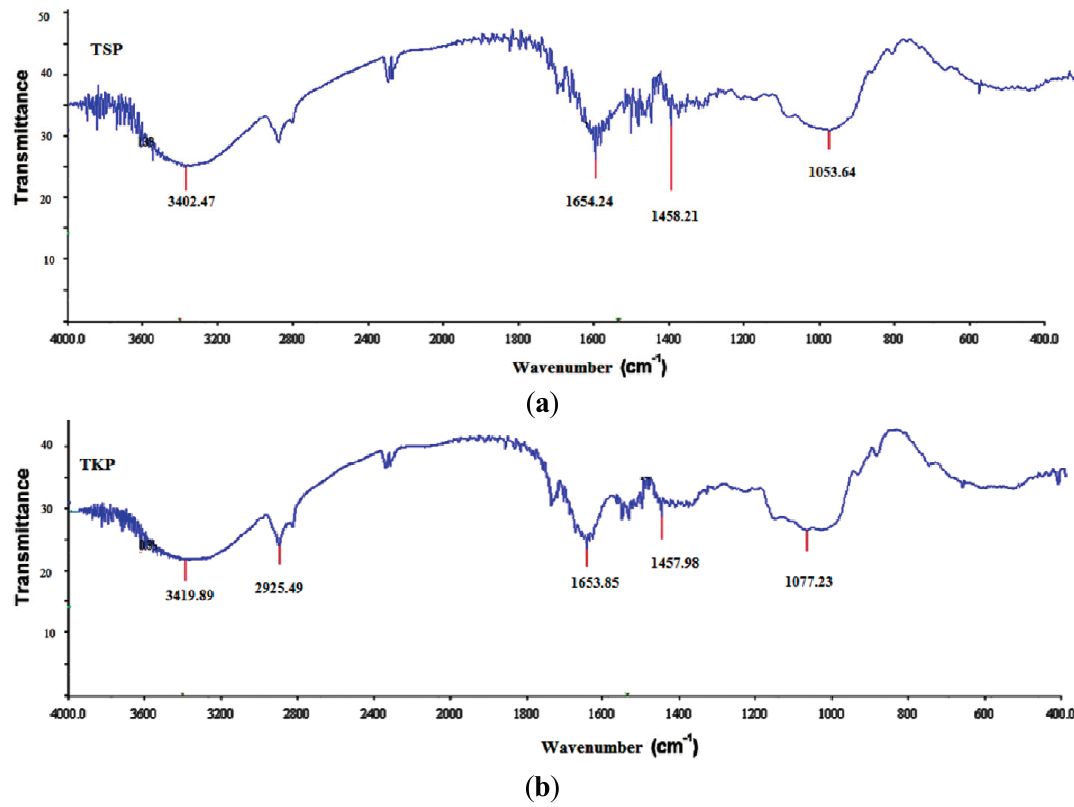
Figure 3. Comparative Fourier Transform infrared spectroscopy (FTIR) of ( a ) TKP and ( b )